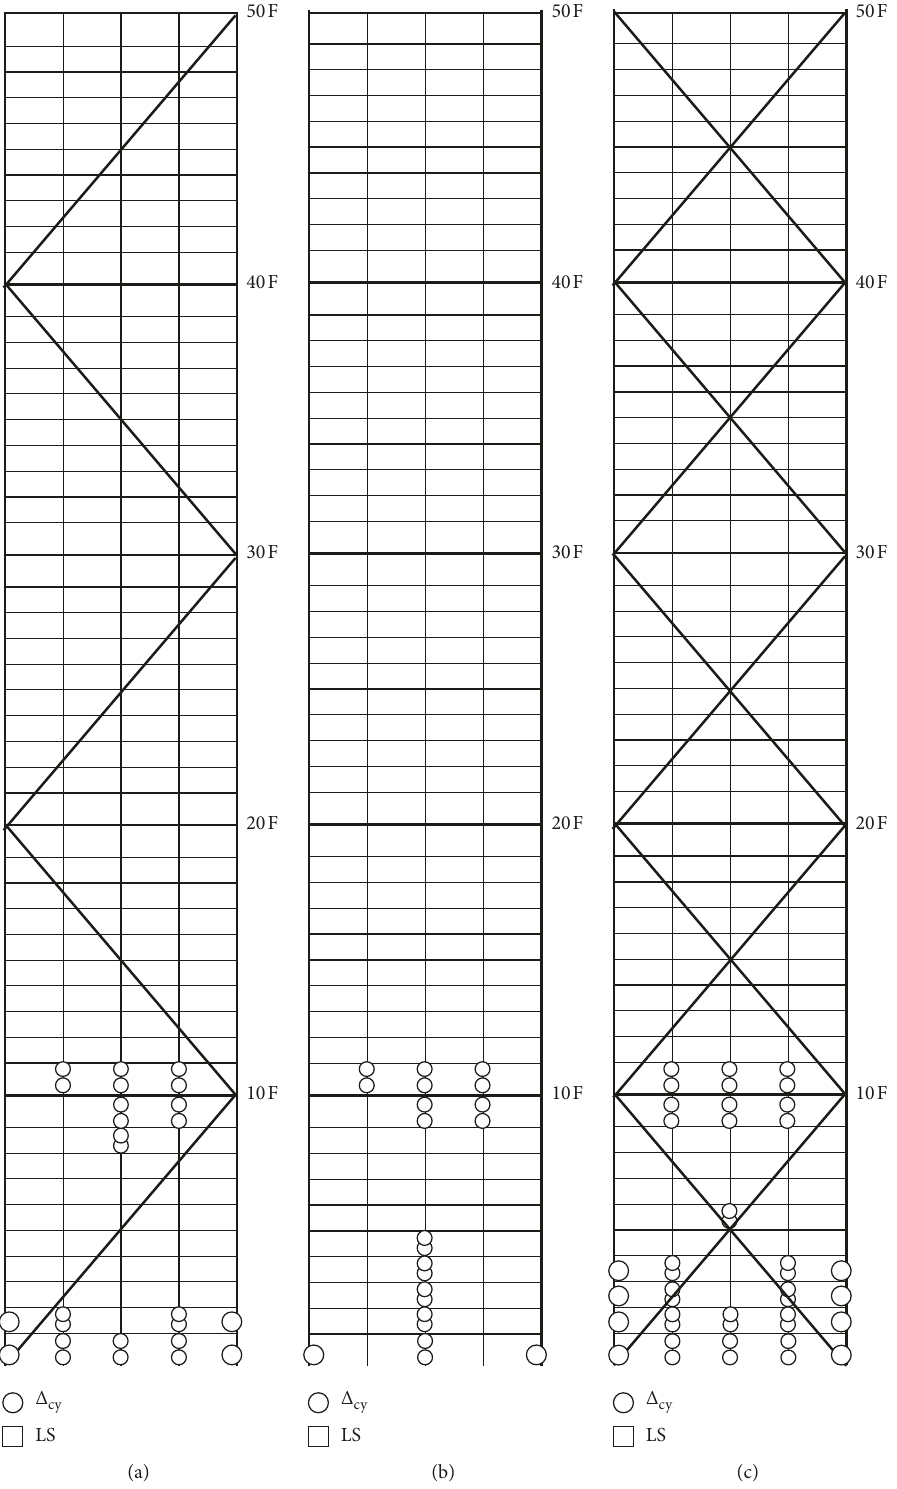
Figure 12: Plastic hinge formation in the flange-side frame of three models at δ